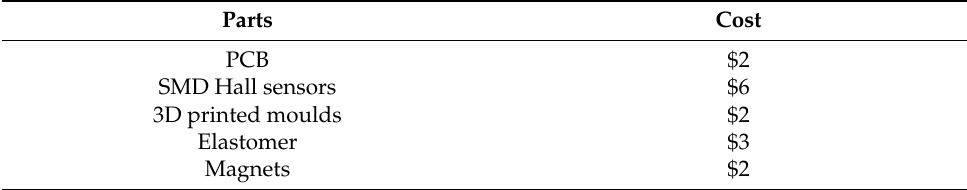
Figure 4. Fabricated sensor with soft material based octagonal-shaped dome for force application. Table 2. Cost of each component for proposed magnetic tactile sensor.